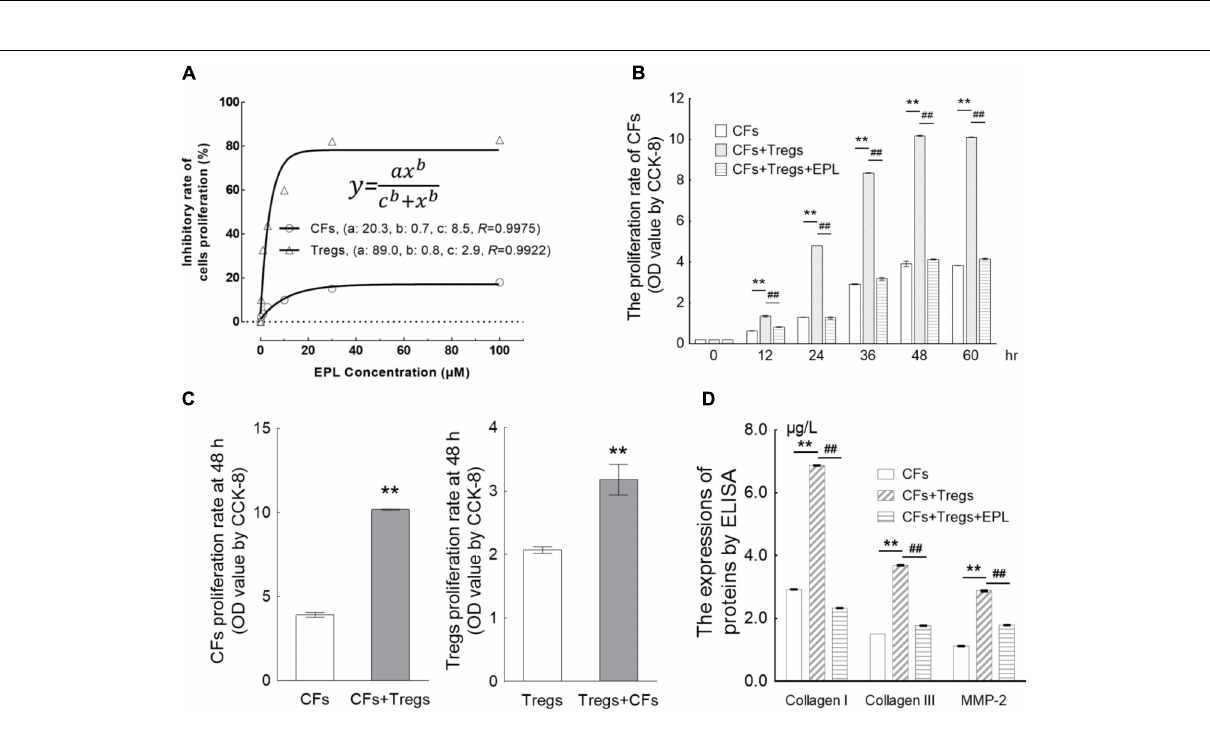
FIGURE 5 | Eplerenone suppresses the proliferation of CFs induced by co-incubation with Tregs. (A) After 48-h treatment of Tregs and CFs with eplerenone at 0.1, 0.3, 1, 3, 10, 30, and 100 µ M, cell viability (by CCK-8 assay, n = 8) of both cell types was inhibited in a concentration-dependent manner in accordance with the Hill equation: y = ax b . The IC 50 s for Tregs and CFs were calculated as 2.9 and 8.5 µ M, respectively. 30 µ M eplerenone suppressed cell viability by 82.77 and 17.94% c b + x b in Tregs and CFs, respectively, after which the viabilities stabilized. Accordingly, 30 µ M was chosen as the eplerenone dose for subsequent experiments. (B) Tregs induced the proliferation of CFs in a time-dependent manner (CFs + Tregs vs. CFs, n = 8, ∗∗ P < 0.01 every 12 h). The percentage of proliferation in the CFs + Tregs group was ∼ 2.6-fold higher than that in the CFs group at 48 h (maximum proliferation was achieved with Tregs induction). 30 µ M eplerenone suppressed the augmented proliferation rate at every time point ( ## P < 0.01), even down to the levels of CF proliferation in the absence of Tregs. (C) After 48 h of co-culture, proliferation of the CFs + Tregs cultures was significantly higher than that of the single cultures: OD values of CFs vs. CFs + Tregs were 3.91 ± 0.14 vs. 10.18 ± 0.03, while those of Tregs vs. Tregs + CFs were 2.07 ± 0.15 vs. 3.18 ± 0.68 ( n = 8, both ∗∗ P < 0.01). (D) After 48-h of CFs + Tregs co-culture, the expression levels of collagen I, collagen III, and MMP-2 (by ELISA assay) were elevated by 2.34-, 2.46-, and 2.57-fold relative to the levels in the CFs cultured alone (CFs + Tregs vs. CFs, n = 8, ∗∗ P < 0.01), whereas they were suppressed to 33.92, 47.97, and 62.15% of these elevated levels by 30 µ M eplerenone treatment (CFs + Tregs + EPL vs. CFs + Tregs, n = 8, ## P <